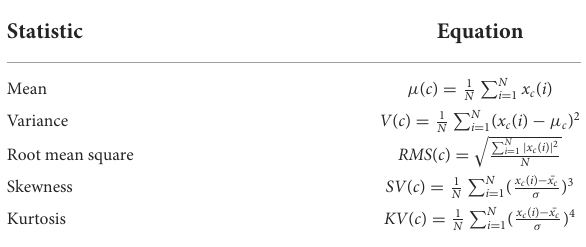
TABLE 2 EEG signal statistics used for channel selection. TABLE 3 Architecture of